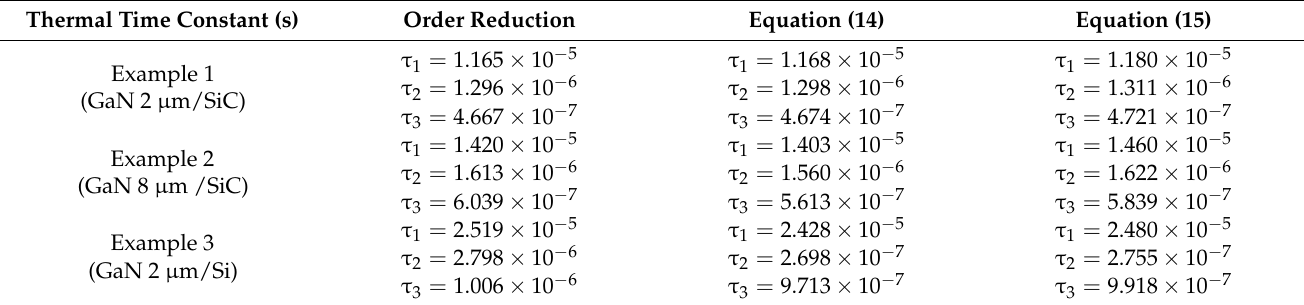
Table 4. Thermal time constants extracted.